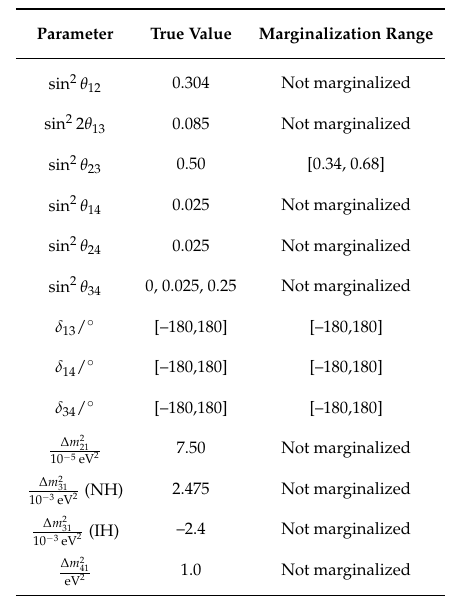
Table 1. Parameter values and ranges used in the simulations. The second column displays the true values of the oscillation parameters used to simulate the true dataset. The third column displays the range over which sin 2 θ 23 and the CP-phases δ 13 , δ 14 , and δ 34 are varied while minimizing the χ 2